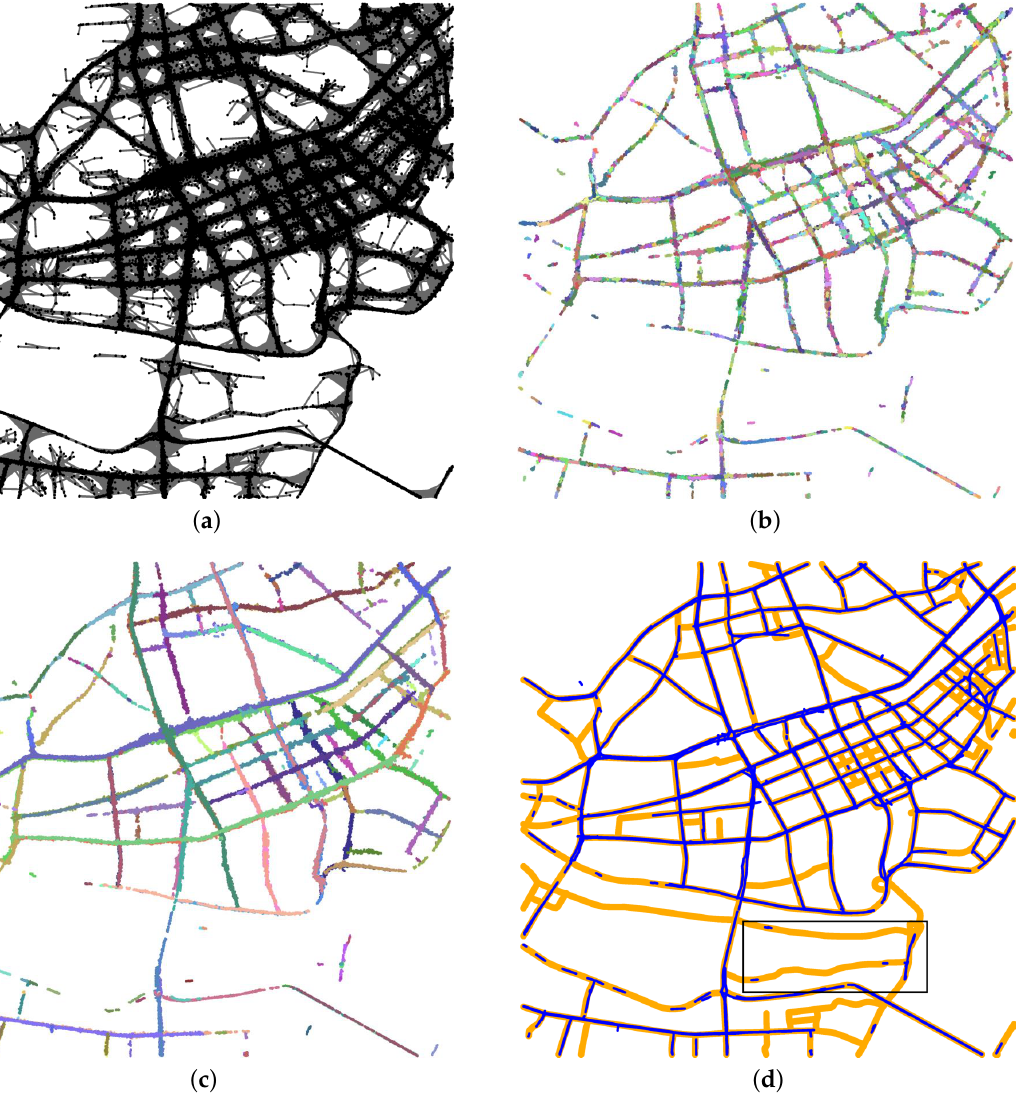
Figure 5. Experiment result of Wuhan dataset. ( a ) Raw GPS traces overlapped with the GPS points collected in Wuhan; ( b ) point clusters generated by the progressive DBSCAN algorithm with an orientation constraint; ( c ) point clusters after progressive grouping; ( d ) the generated road map (blue lines) overlapped with the ground truth map (yellow lines) of